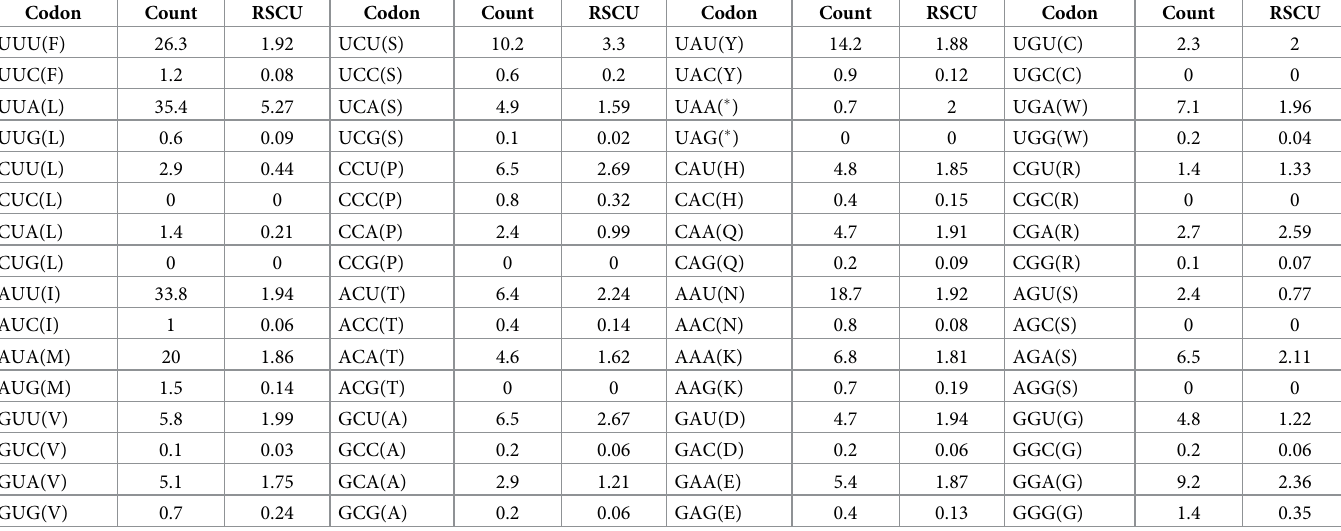
Table 2. Codon usage and relative synonymous codon usage (RSCU) within Chrysodeixis acuta mitochondrial